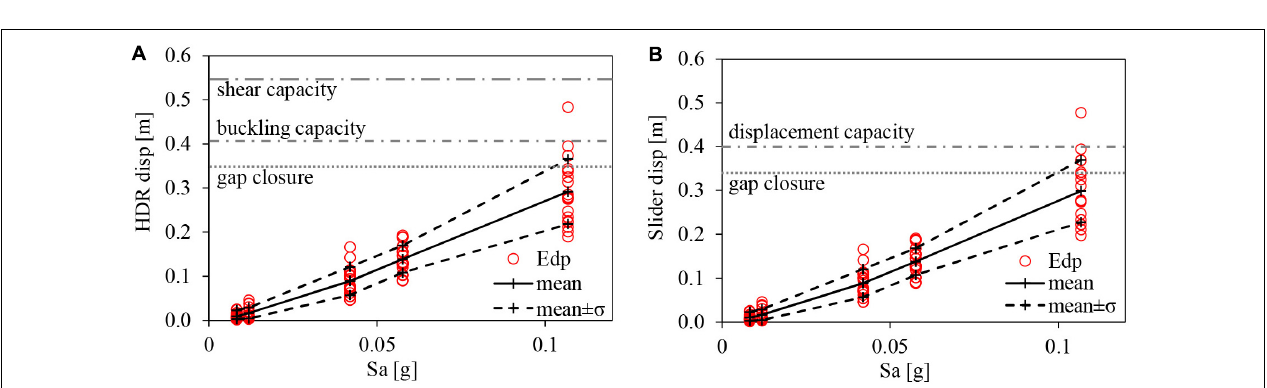
FIGURE 8 | Maximum displacement of HDR bearings (A) and sliders (B) and the corresponding capacity limits.